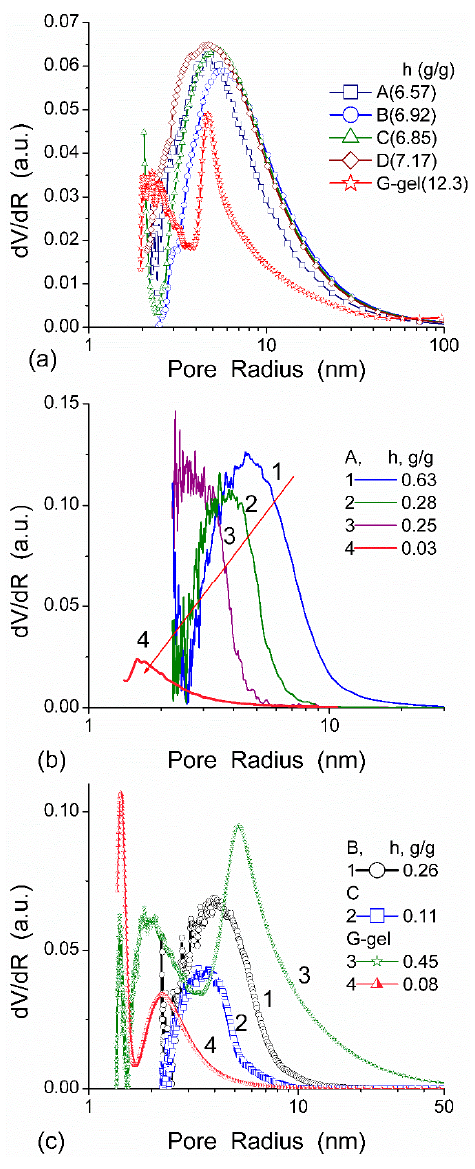
Figure 3. PSDs calculated from the DSC data for HEMA-AGE (A, B, C, and D samples) and G gels (hydration h = m w / m d where m w is the weight of water evaporated in DSC measurements up to 160 °C and m d is the residual weight of heated sample) at ( a ) high and ( b , c ) low hydration (reproduced from Ref. [47] with permission from The Royal Society of Chemistry).